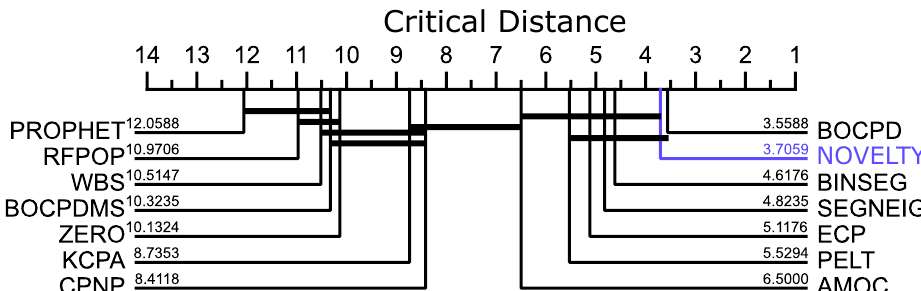
Figure 10. Critical distance diagram comparing the methods used in [8] (except RBOCPDMS ) and the novelty function on Dataset 5 (CPDBenchmark, see Section 3.5). The performance measure corresponds to the F1-score for all single-dimension datasets of the benchmark, except for the ones identified in Table 3 with a grey background. A thick horizontal line groups a set of classifiers that are not significantly different in the statistical test